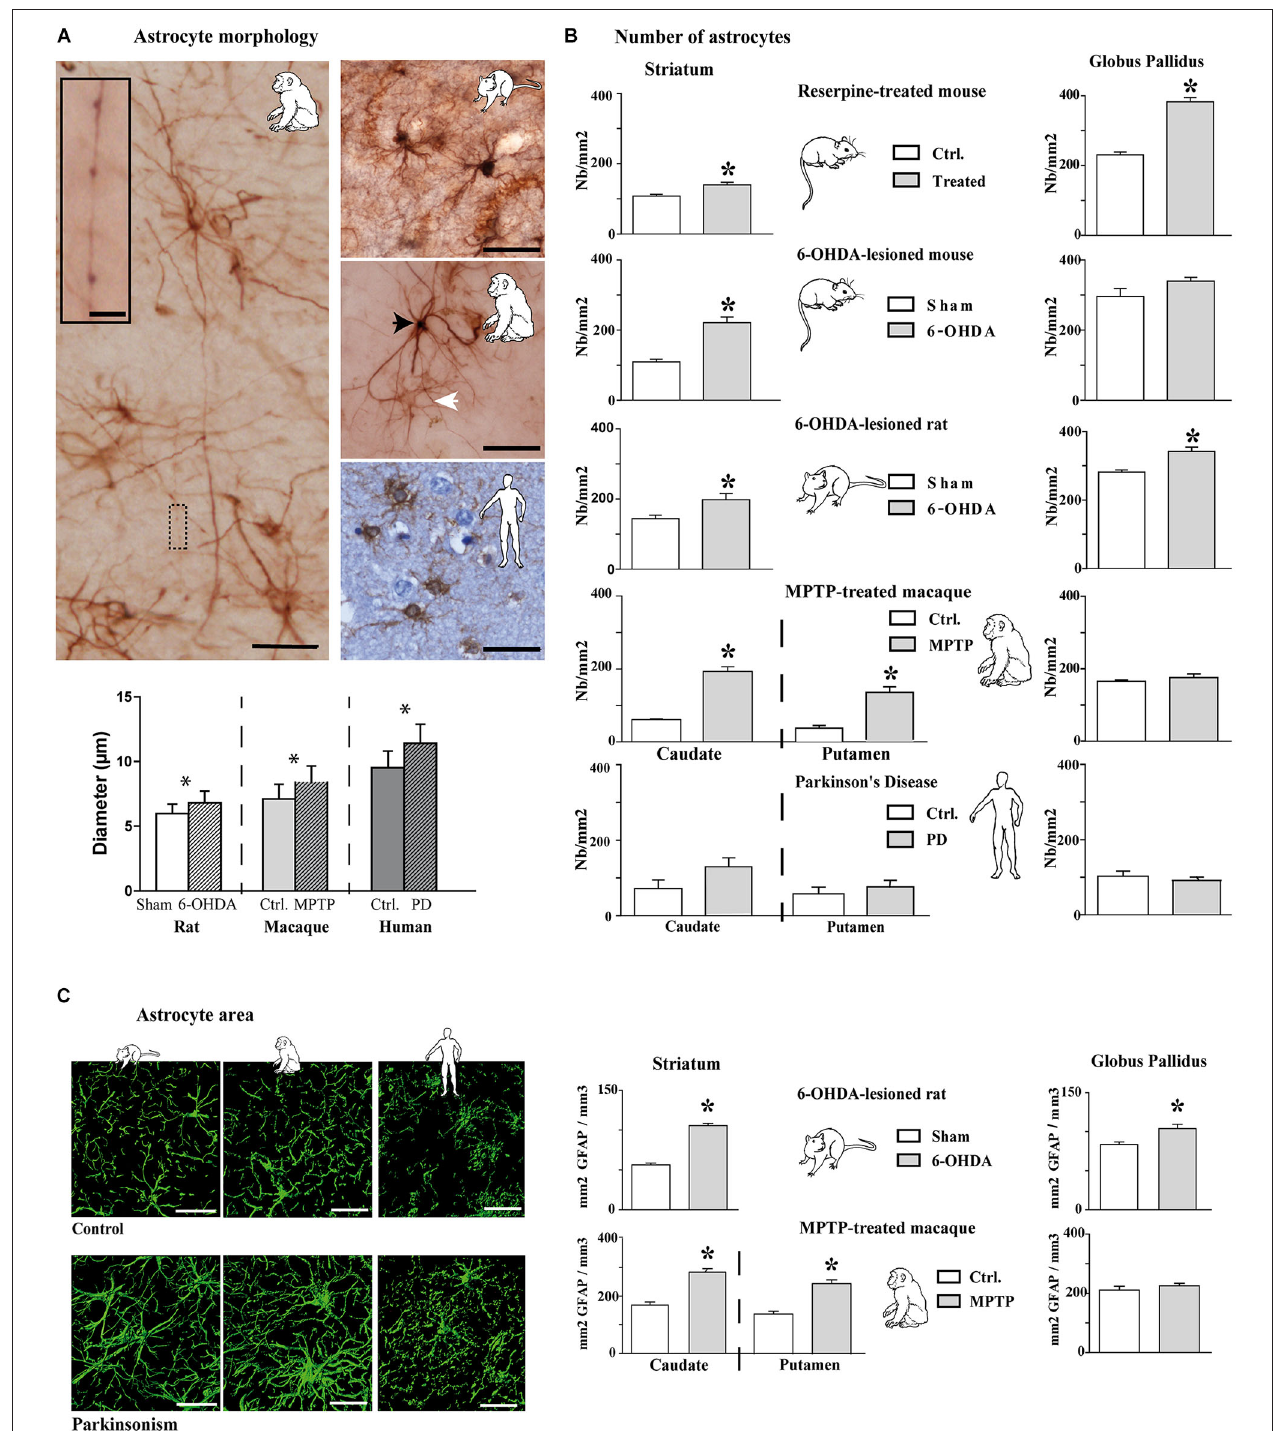
for intense labeling and a white arrowhead for moderate staining. (B) Quantitative analysis of astrocyte number in striatum and GP in controls and in animal models of PD ( n = 4 reserpine mouse, n = 5 6-OHDA mouse, n = 4 6-OHDA rat, n = 3 MPTP non-human primate) as well as in parkinsonian patients ( n = 3) showing increase in astrocyte number. * denotes a significant difference (Student t -test; p <